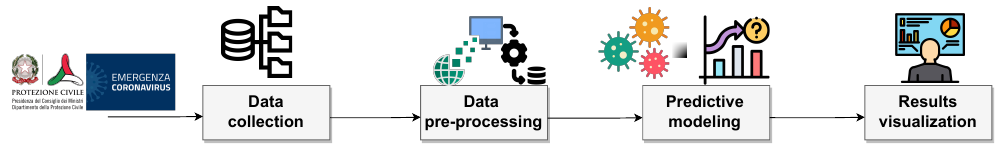
Figure 1. Proposed approach